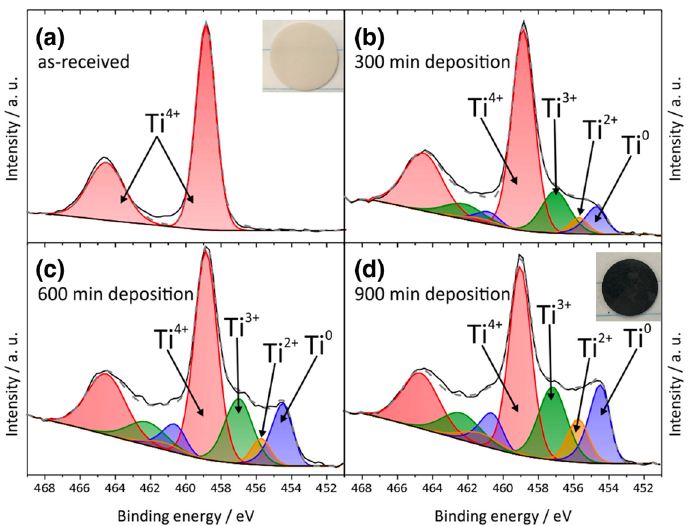
Figure 9. X-ray photoelectron spectroscopy (XPS) detailed spectra of four Ti oxidation states for four different deposition times. Reprinted from [84], Copyright (2015), with permission from Elsevier.